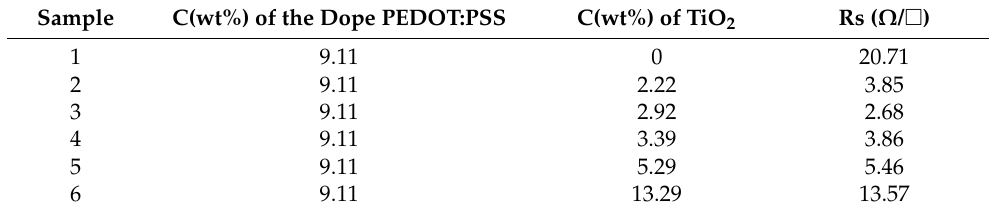
Table 1. Sheet resistance (Rs) of reference and nanocomposite PEDOT:PSS/TiO 2 cotton fabrics.